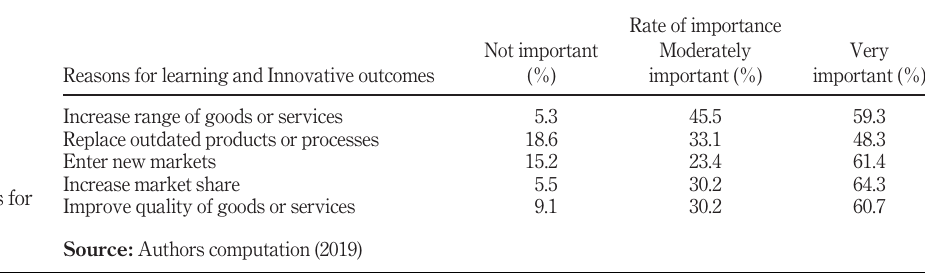
Reasons for learning and Innovative